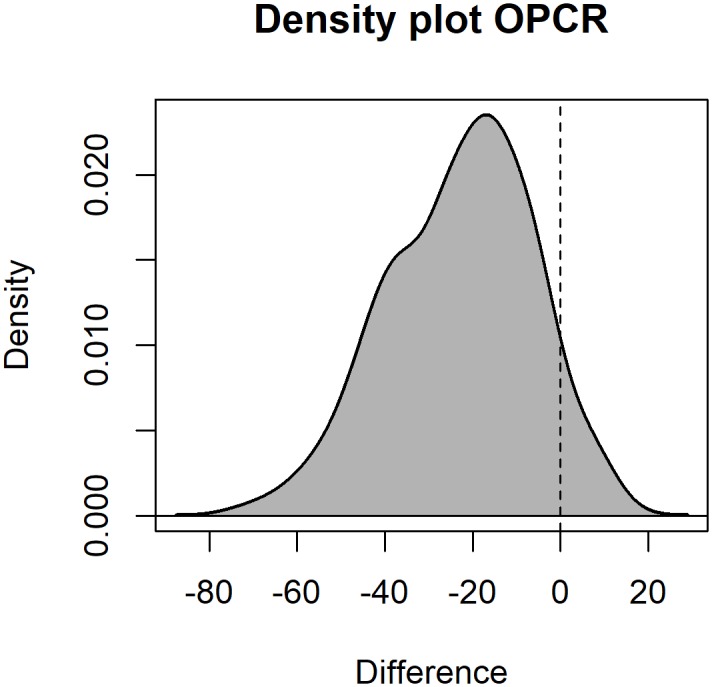
Density distributions of differences in OPCR values for a set of 216 individuals.Difference = OPCRWinchester et al., 2014 –OPCRBerthaume et al., 2019. 93.5% of the OPCR values published here are higher than in [15].